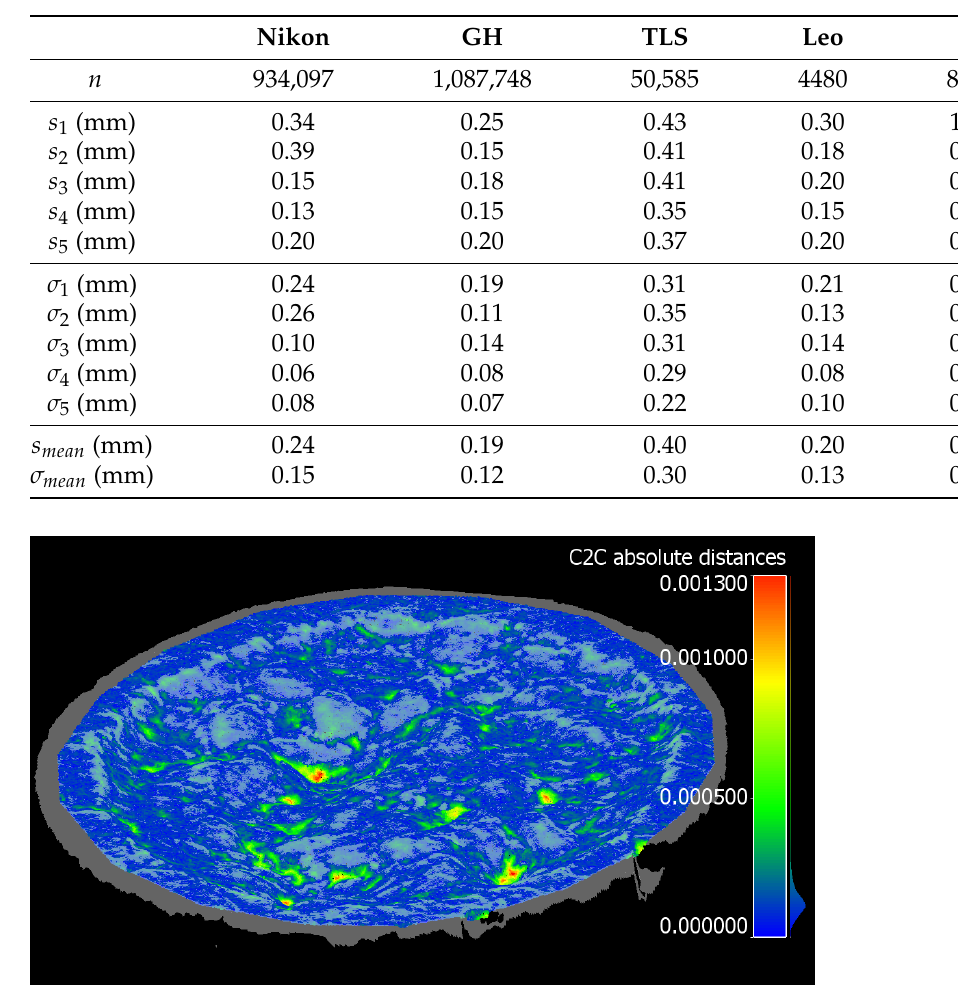
Table 8. Reference measurement results and point cloud sizes, where s is the mean distance to nearest point for reference blocks separately and together, σ is standard deviation, and n the number of points. Nikon: high-resolution photogrammetry; GH: industrial camera photogrammetry; TLS: terrestrial laser scanning; Leo: Artec Leo; FF: Faro Freestyle.